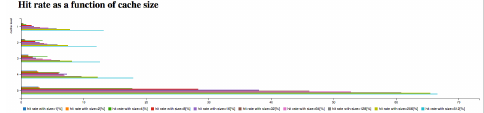
Figure 3: Example hitrate performance of a net- worked